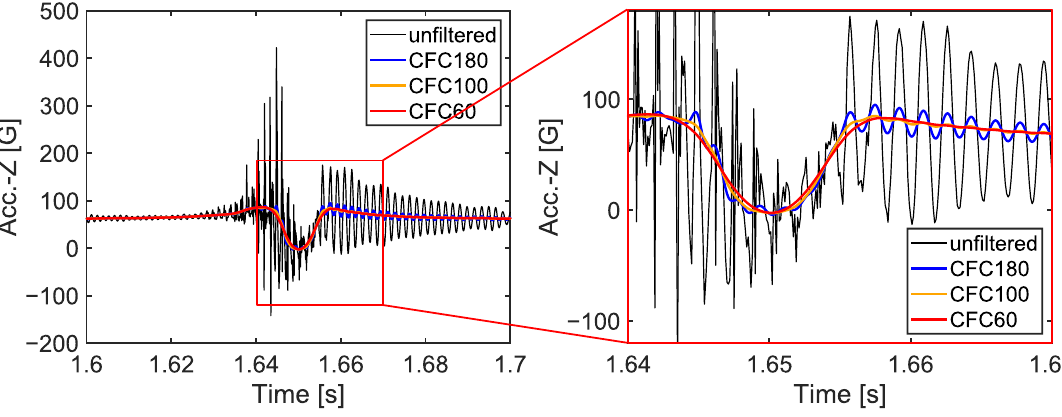
Figure 6. Average acceleration time histories from the three consecutive